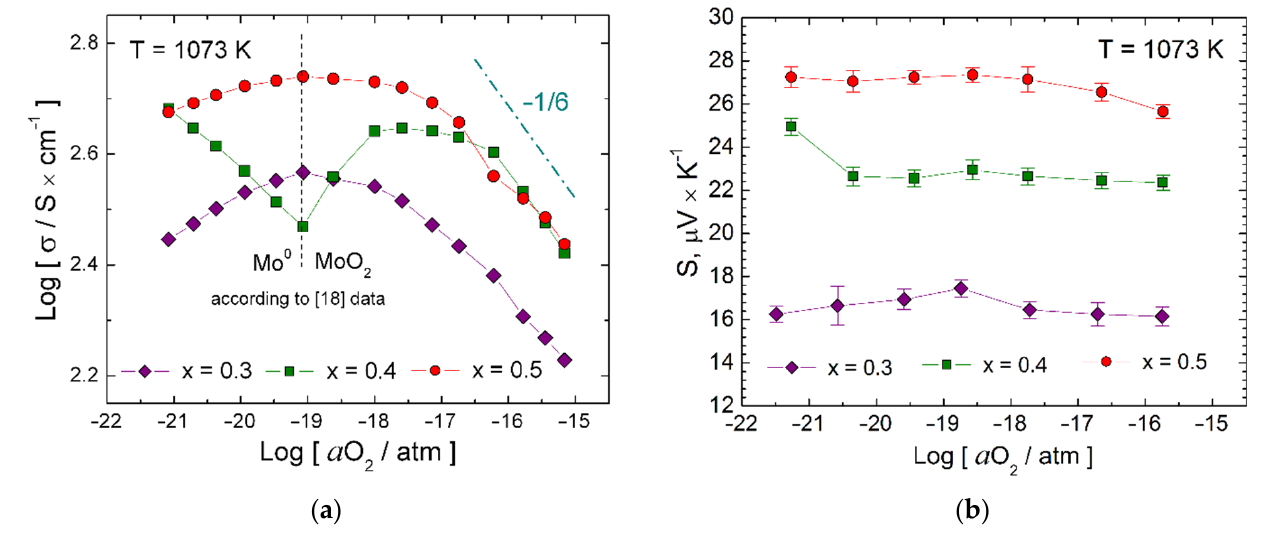
Figure 5. The dependencies of conductivity ( a ) and Seebeck coefficient ( b ) of CaV 1–x Mo x O 3± δ (0.3 ≤ x ≤ 0.5) ceramics on a O 2 at 1073 K. (0.3 ≤ x ≤ 0.5) ceramics on a O 2 at 1073